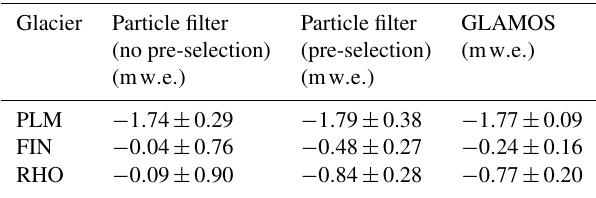
Table 3. Mass balances calculated with the particle filter between the autumn field dates of 2018 and 2019 against the values reported by GLAMOS. See text for the difference of particle filtering with and without pre-selection. Uncertainty values are given as standard